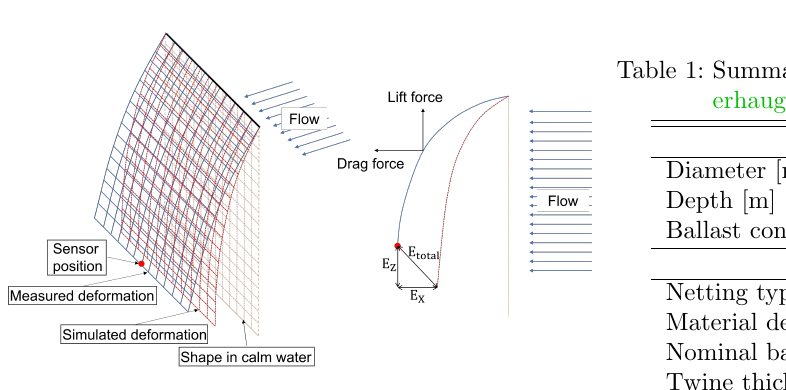
Figure 5: Deformation of net panel under current loads. E total represents the total positional discrepancy on the middle bottom point of the panel. E Z and E X are the components of E total in vertical and horizontal directions respectively.